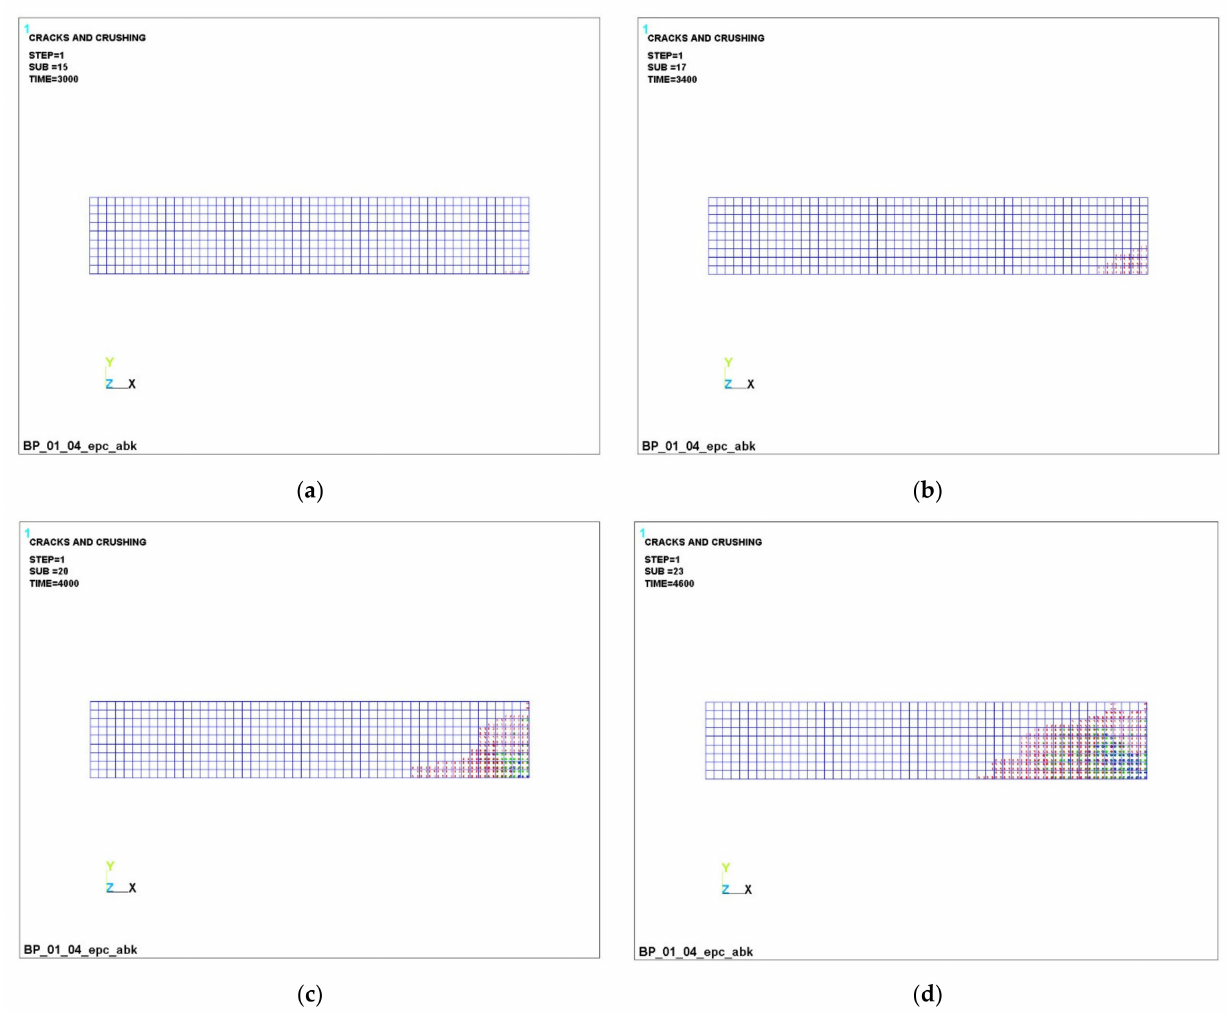
Figure 9. Successive cracking in concrete with BCR under load: ( a ) –3000 N; ( b ) –3400 H; ( c ) 4000 H; ( d ) –4600 H.